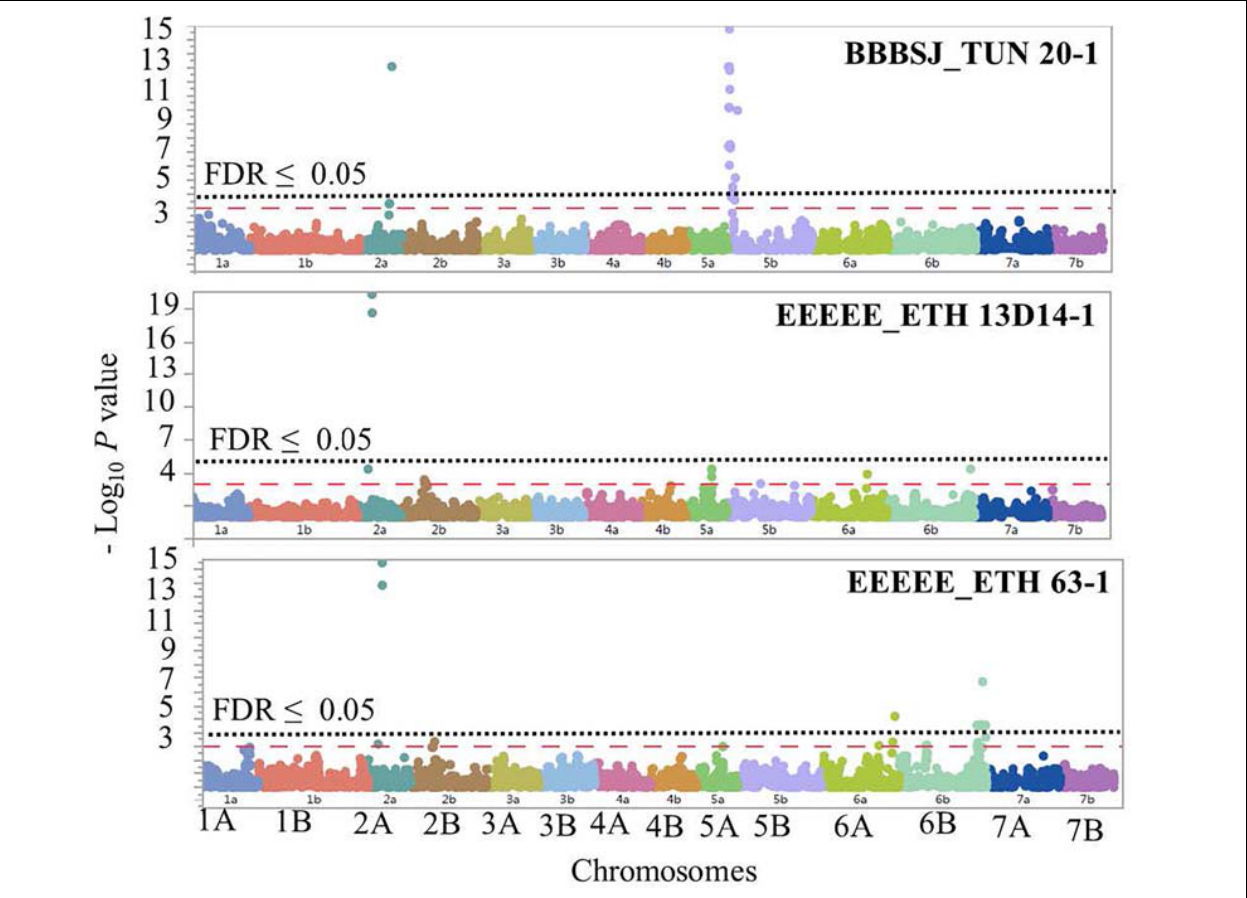
FIGURE 6 | Manhattan plots showing P -values for single-nucleotide polymorphism (SNP) markers associated with response to leaf rust in durum wheat genotypes to the three durum wheat type isolates BBBSJ_TUN 20-1, EEEEE_ETH 13D14-1, and EEEEE_ETH 63-1. The horizontal dashed red line indicates significance level at P -value ≤ 0.001. The horizontal dotted black line indicates significance level at FDR ≤ 0.05.